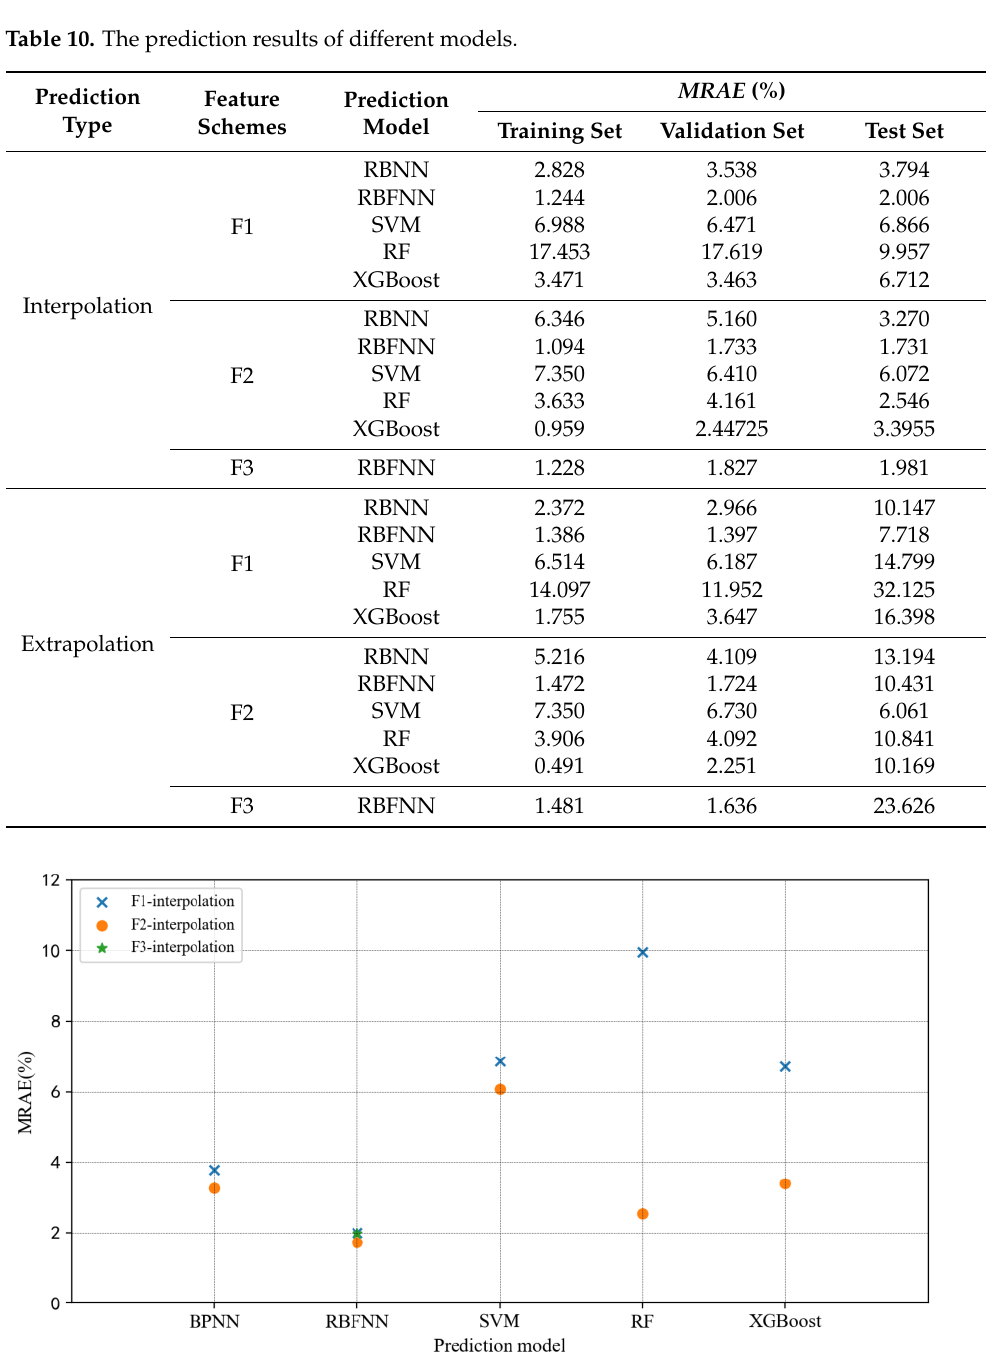
Figure 9. The MRAE of extrapolation prediction under different models. The optimal predicted resistance coefficient C t is converted to the corresponding re- sistance R t . The experimental values and predicted values of each sample point in the test set are shown in Table 11. The curves of C t versus Fn and the curves of R t versus V m at draft = 0.209 m and draft = 0.275 m are shown in Figures 10 and 11, respectively. 